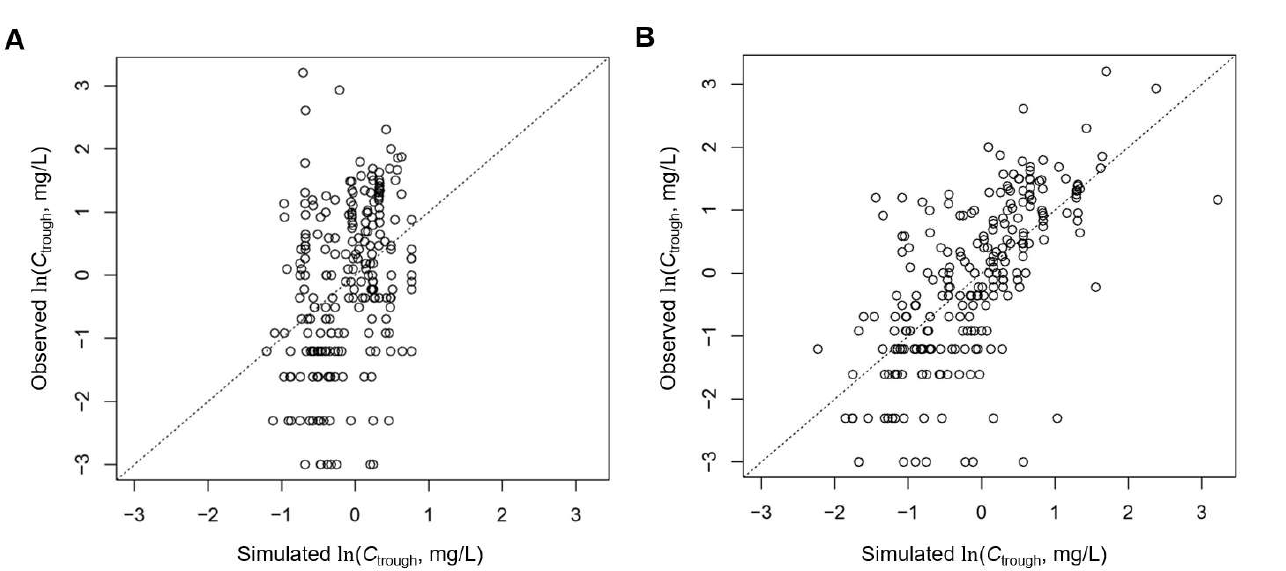
Figure 4. Observed ln( C through ) versus simulated ln( C through ). ( A ) Before inclusion of covariates for co-medications and genetic variants in the model. ( B ) Final model in Table 4. Both plots, population level (no random effects included).